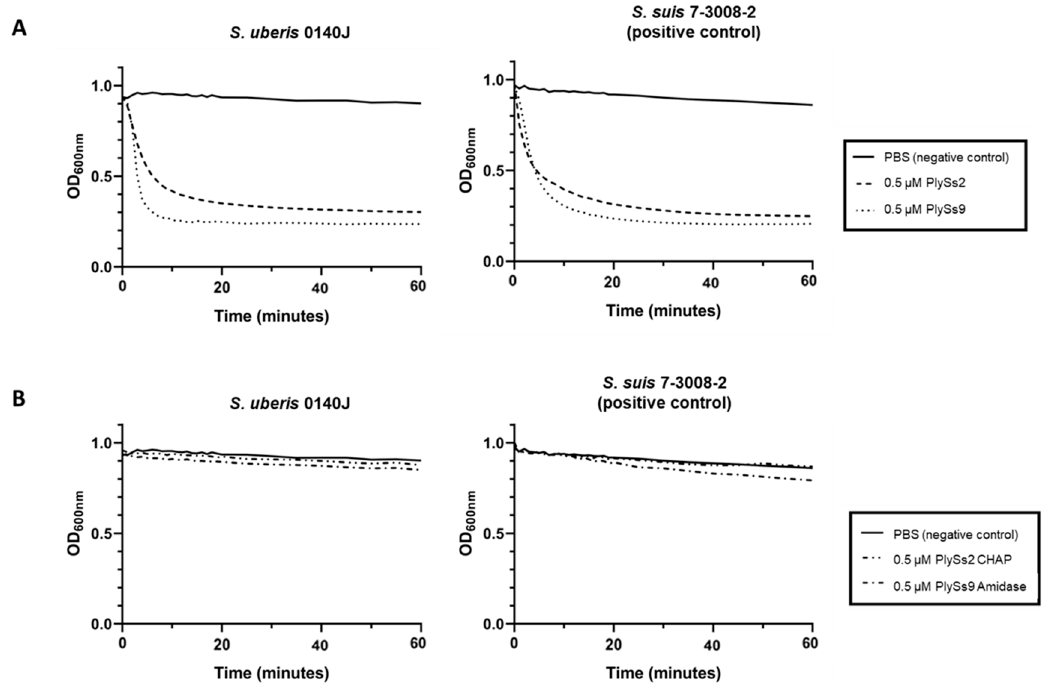
Figure 3. Turbidity reduction assays with 0.5 µ M of PlySs2 and PlySs9 ( A ), and PlySs2 CHAP and PlySs9 amidase ( B ) on stationary phase S. uberis 0140J and S. suis 7-3008-2, the latter pathogen being included as a positive control. Bacteria in PBS served as negative